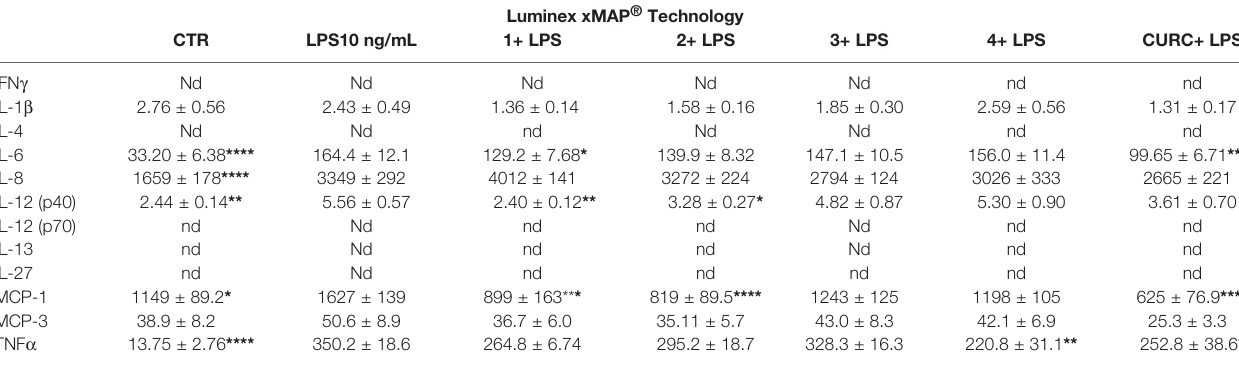
TABLE 2 | Differential regulation of innate immune cytokine release in human PBMCs from healthy